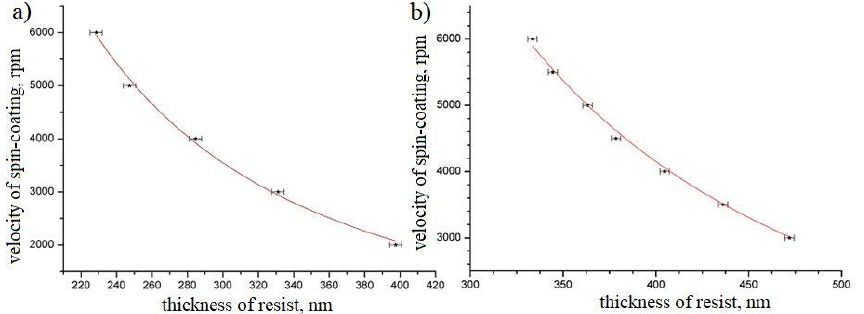
Fig. 1. Experimentally obtained thicknesses of the resists ma-N 2403 (a) and ZEP 520A (b) spin-coater rotation speed. The second order power function was